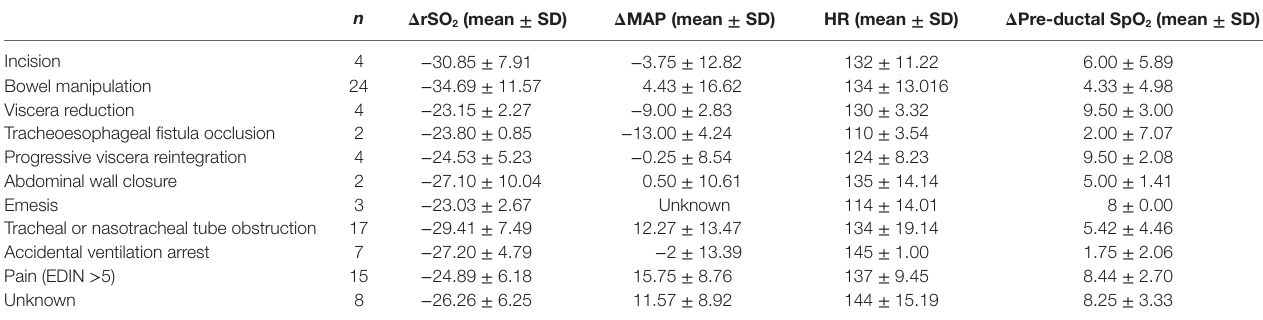
TaBle 5 | Repartition of pathological rSO 2 and corresponding mean arterial pressure (MAP) (mmHg), heart rate (HR) (bpm), and pre-ductal SpO 2 values, in regard to acute event.